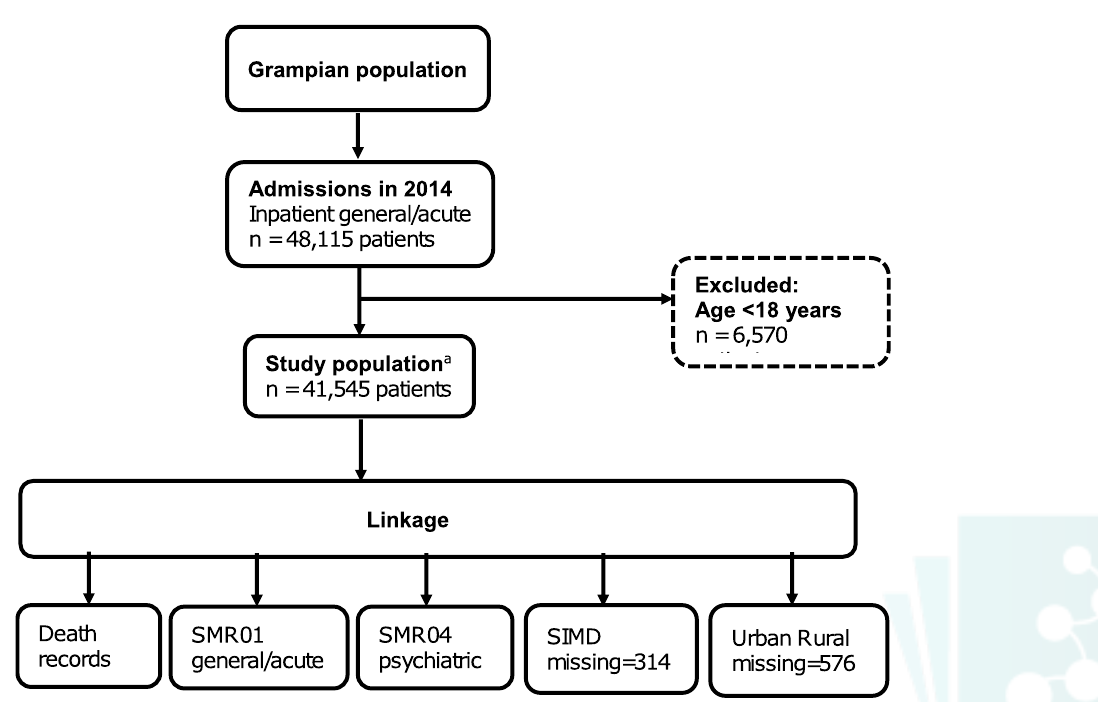
Figure 2: Flowchart of study population and data